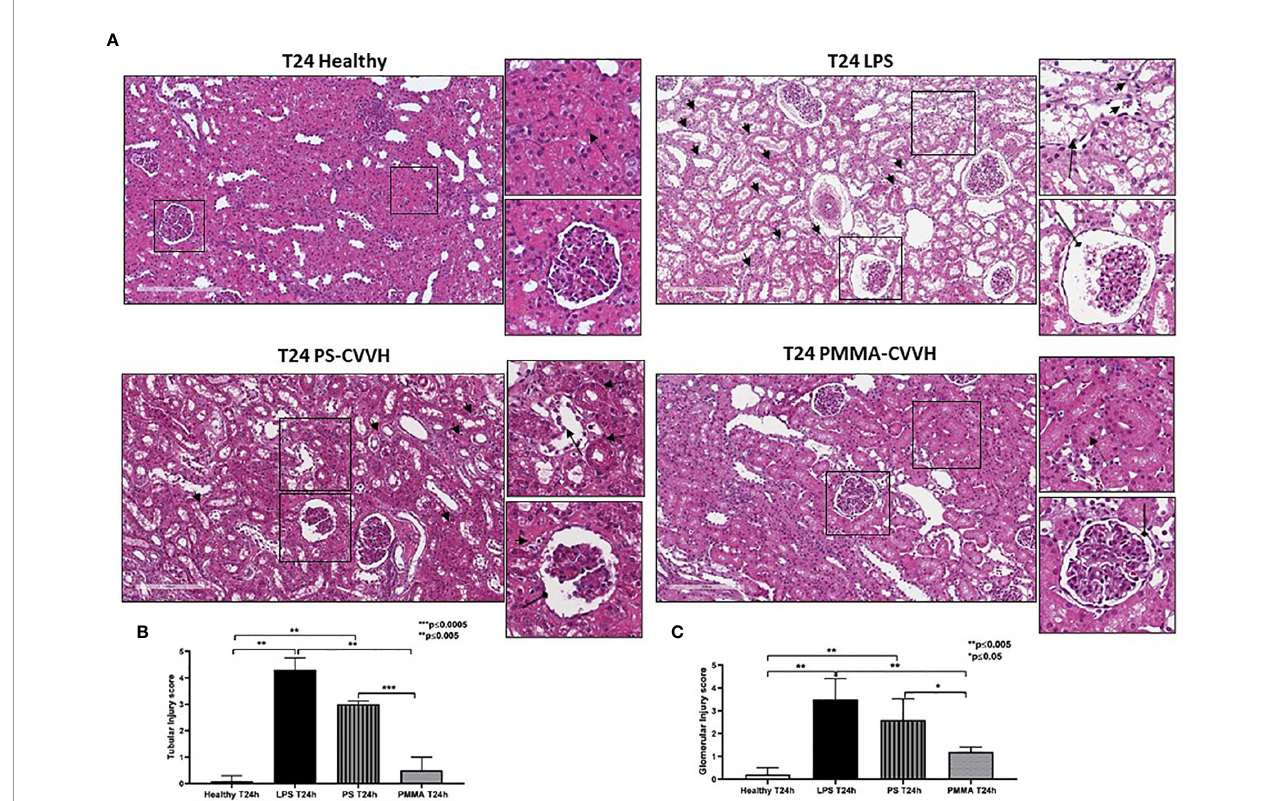
FIGURE 2 | Recovery of parenchymal damage in endotoxemic animals. (A) H&E staining showed signi fi cant desquamation of proximal tubular epithelial cells (zoomed image, black arrow), marked fi brin deposition and loss of capillaries in numerous glomeruli, Bowman ’ s capsule expansion (zoomed image, black arrow with rounded tip), and interstitial in fl ammatory in fi ltrate (T24 LPS and zoomed image, small black arrows) after 24 h from LPS infusion compared to control (T24 Healthy). PS-CVVH treatment reduced in fl ammatory in fi ltrate (small black arrows) but not preserved glomerular (loss of capillaries and Bowman ’ s capsule expansion; zoomed image, black arrow with rounded tip) and tubular compartment from LPS injury (zoomed image, black arrow). In PS-CVVH group, few tubules did not show signs of damage and vacuolization (zoomed image, dotted arrows). Renal biopsies of endotoxemic animals after PMMA-CVVH treatment showed recovery of tubular damage (zoomed image, dotted arrow) and reduced pathological changes at glomerular level (zoomed image, black arrow with rounded tip) and in fl ammatory in fi ltrate (zoomed image, black arrows). (B, C) Tubular and glomerular pathological score was obtained as described in the Methods section and expressed as median ± IQR of at least fi ve pigs for each group (Healthy and PMMA T24 group, n = 7, LPS T24 n = 5, PS T24 n = 6). Statistically signi fi cant differences were assessed by the Mann – Whitney test (*p < 0.05; **p < 0.005; ***p <